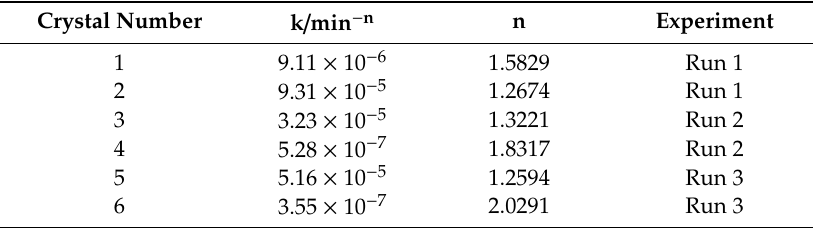
Table 2. Formation rate constants and Avrami exponents obtained from the enclathration-controlled step for six crystals.